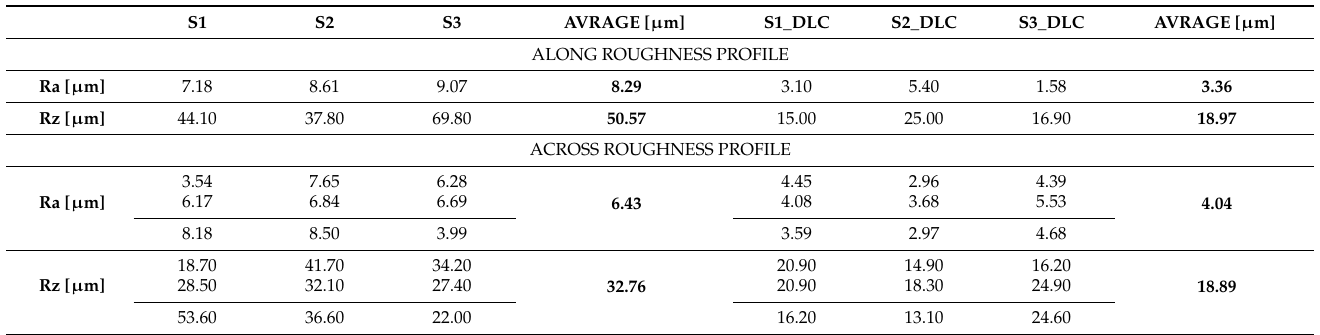
Table 4. The roughness parameters obtained based on the roughness profiles for struns before and after modification with DLC coatings.